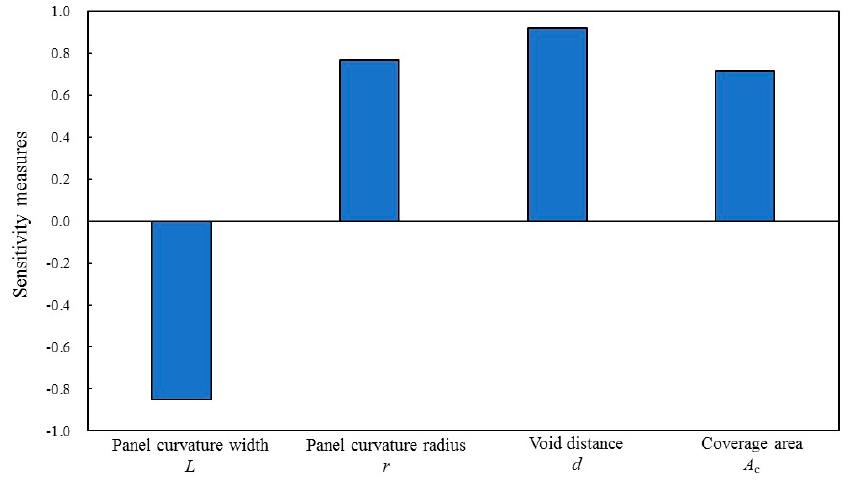
Figure 14. Sensitivity analysis of four dependent design parameters.